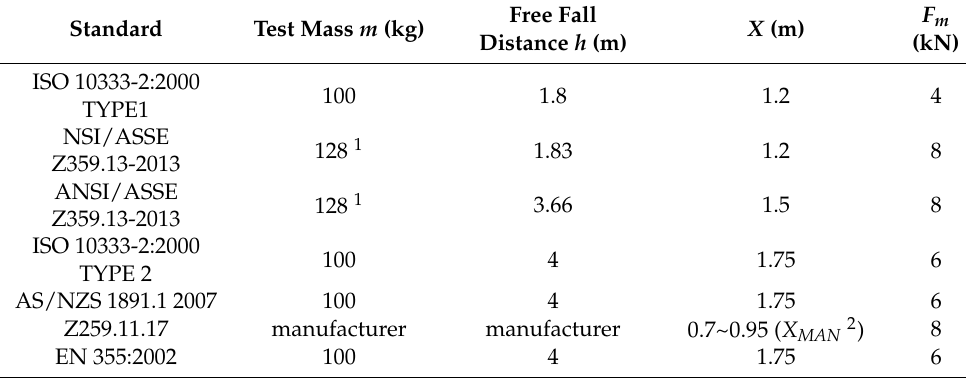
Table 1. International standards